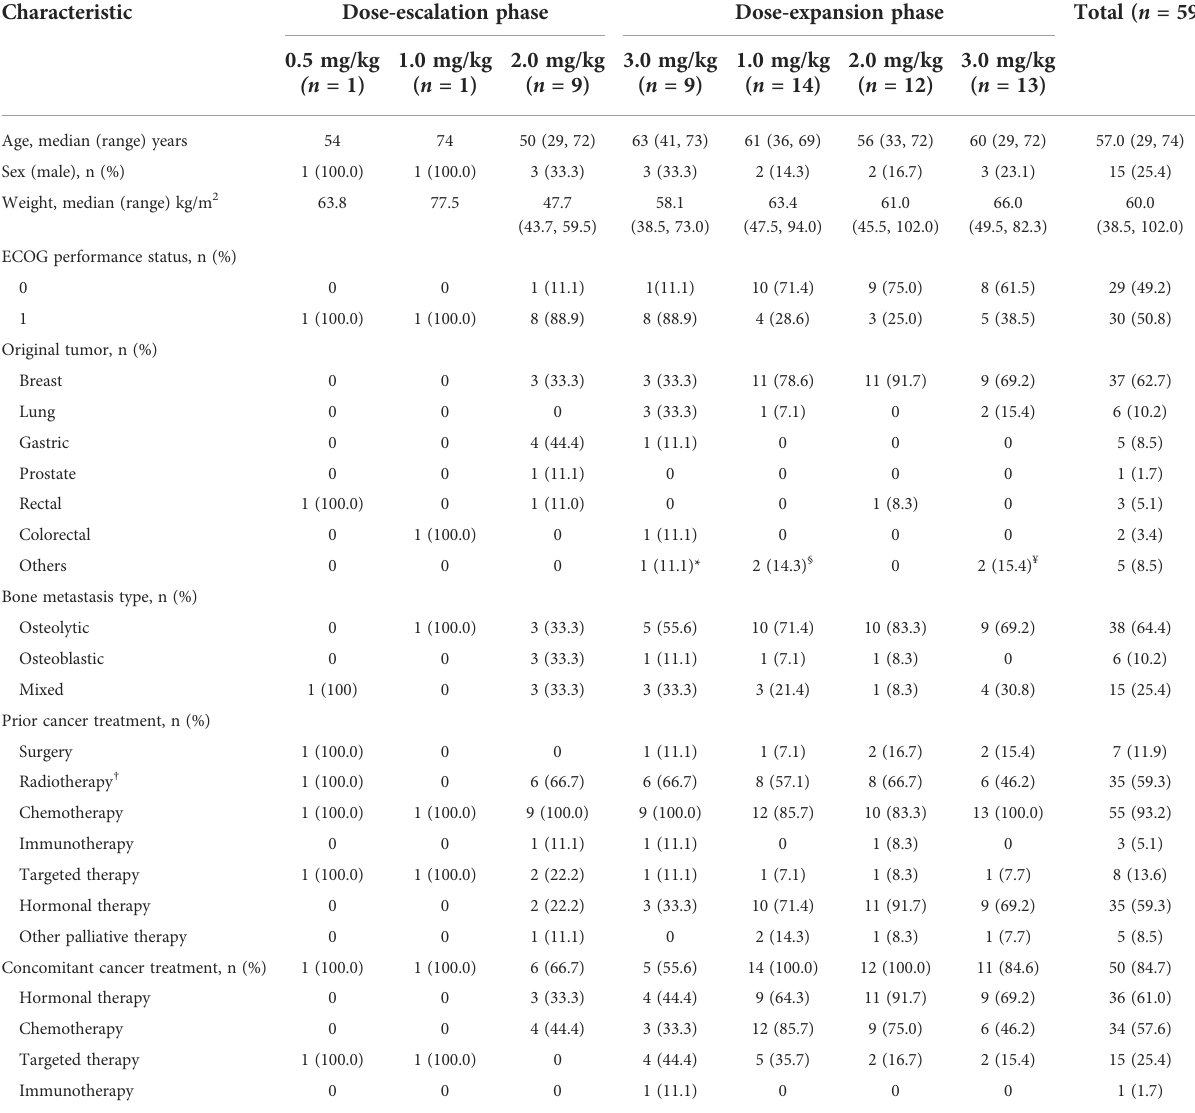
TABLE 1 Demographics and baseline characteristics of 59 Chinese patients with bone metastases from solid tumors.